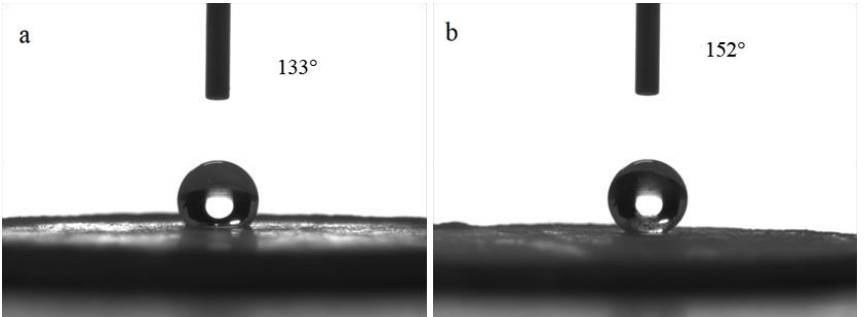
Figure 4. The influence of polishing on the contact angle of bulk material: ( a ) before polishing, ( b ) after polishing.